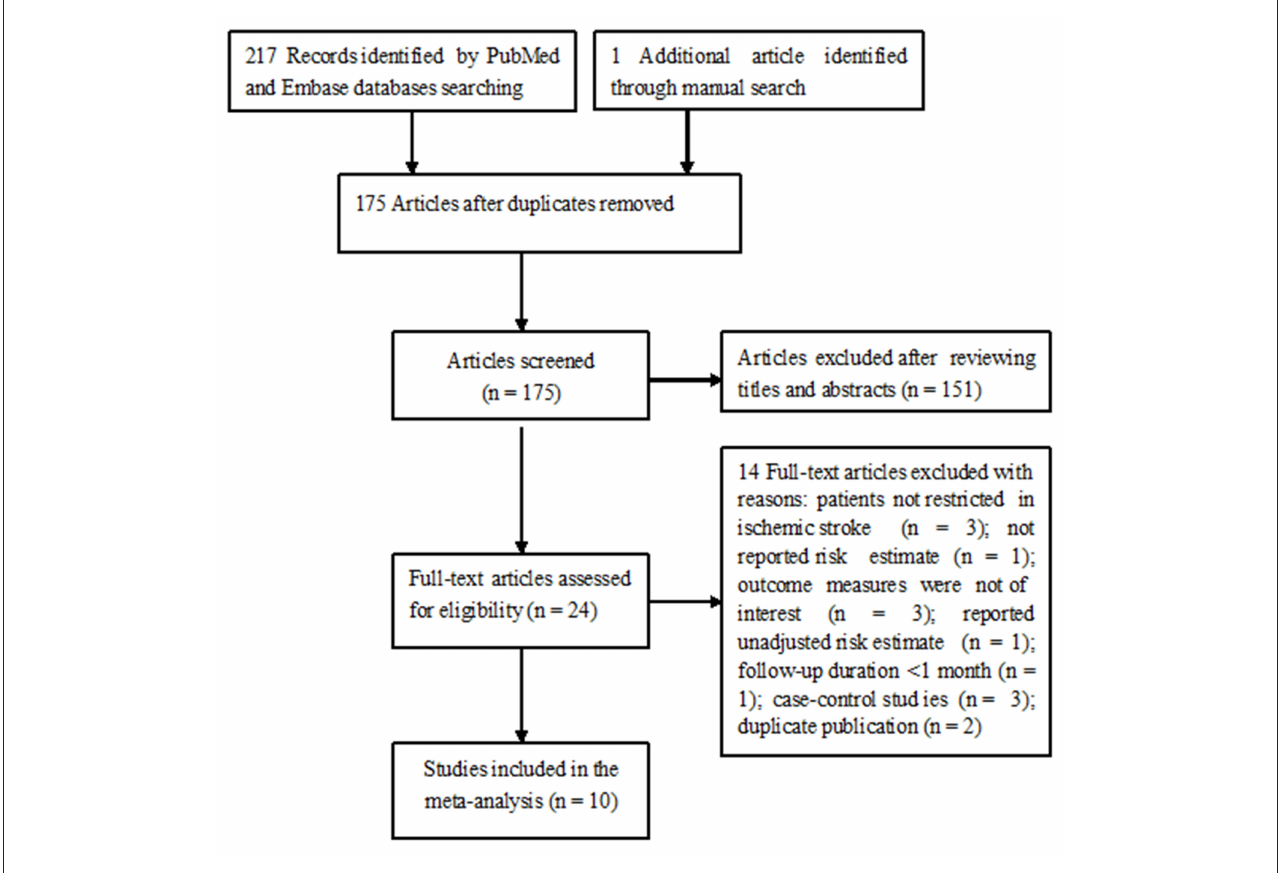
FIGURE1 Flow chart of the study selection